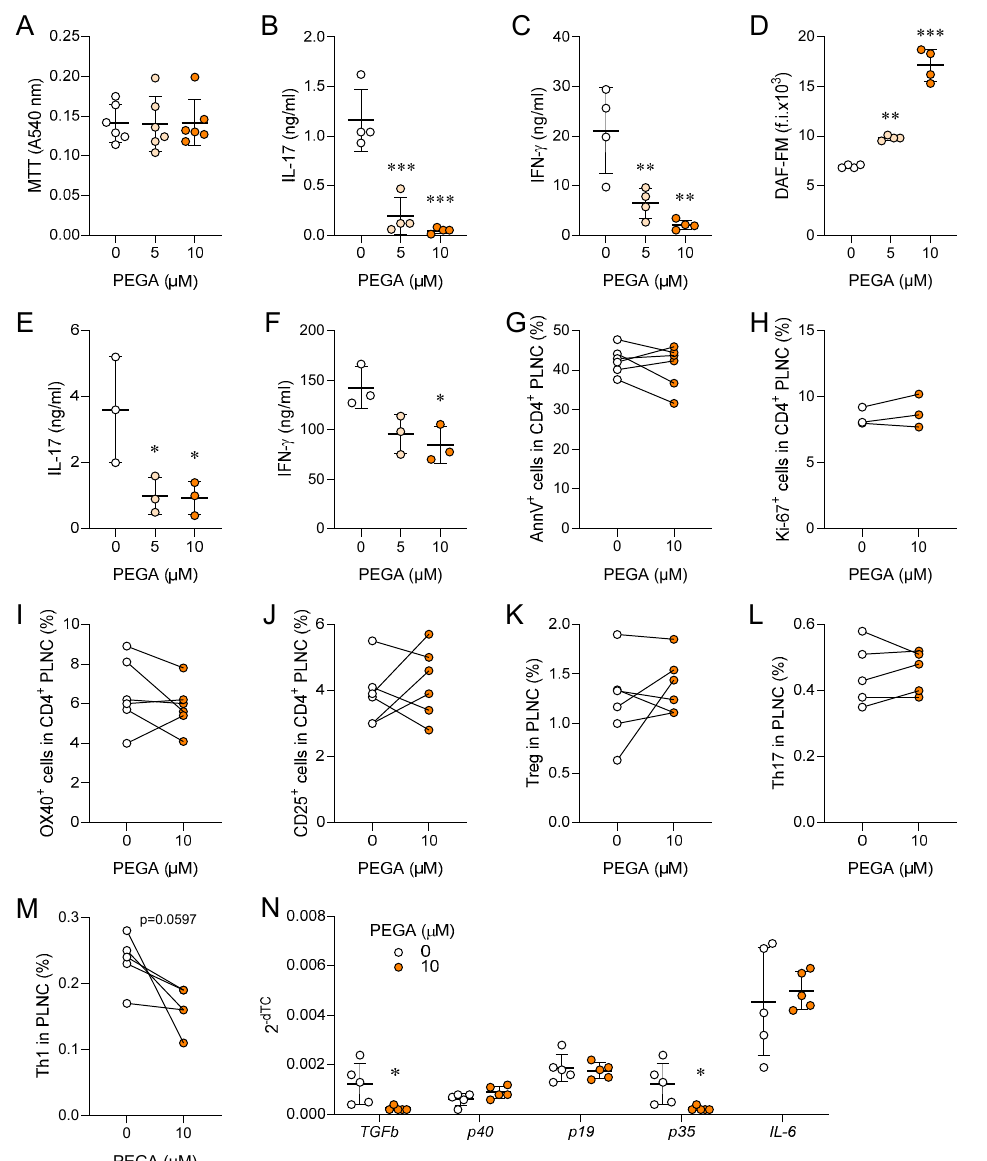
Figure 1. Immunomodulatory effects of PEGA on PLNC. Rats were immunized with myelin oligodendrocyte glycoprotein (MOG) 35-55+CFA ( A – F ) or with spinal cord homogenate (SCH) ( G – N ). PLNC were isolated on day 6 p.i. and stimulated with MOG35-55 ( A – D ), or with MBP ( G – N ), or with phorbol 12-myristate 13-acetate (PMA) and ionomycin in the presence of brefeldin A for 4 h before staining ( L , M ). CD4+ cells were purified from PLNC obtained on day 6 p.i. and stimulated with anti-CD3 and anti-CD28 antibodies ( E , F ). The cells were cultivated in the absence (0) or presence of PEGA for 24 h and cell viability was determined with 3-(4,5-dimethylthiazol-2-yl)-2,5-diphenyltetrazolium bromide (MTT) ( A ), Cytokine levels were determined in cell culture supernatants by ELISA ( B , C , E , F ), 4-amino-5-methylamino-2 ′ ,7 ′ -difluorofluorescein diacetate (DAF-FM) was measured by fluorimetry ( D ), Apoptosis was determined by Annexin V staining ( G ), proliferation was measured by Ki67 staining ( H ), activation was assessed by CD25 ( I ) and OX40 staining ( J ) in CD4 + T cells by flow cytometry. Treg were identified as CD4 + CD25 + Foxp3 + cells ( K ), Th17 as CD4 + IL-17 + cells ( M ), and Th1 as CD4 + IFN- γ + cells ( M ) by flow cytometry. Relative levels of cytokines mRNA were determined by “real-time” RT-PCR ( N ). Individual values of 3 ( E , F , H ), 4 ( B – D ), 5 ( L – N ), or 6 ( A , G , I – K ) samples are presented. In addition, the mean values +/ − SD are given ( A – F ) One-way ANOVA followed by Tukey’s multiple comparison test ( A – F ), paired Student’s t -test ( G – M ), and unpaired Student’s t -test ( N ), * p < 0.05, ** p < 0.01, *** p < 0.001, vs.